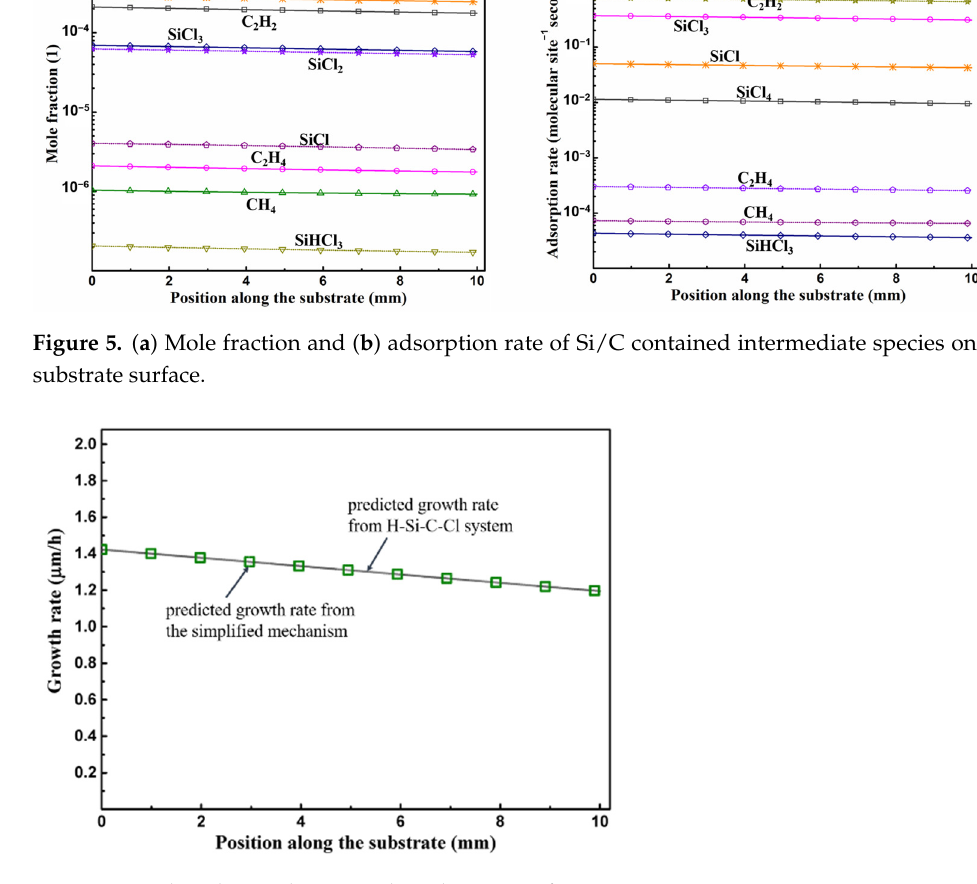
Figure 6. Predicted growth rate on the substrate surface. Table 4. Surface reaction mechanism for SiC from H-Si-C-Cl system. Table 5. Simplified kinetic mechanism for surface